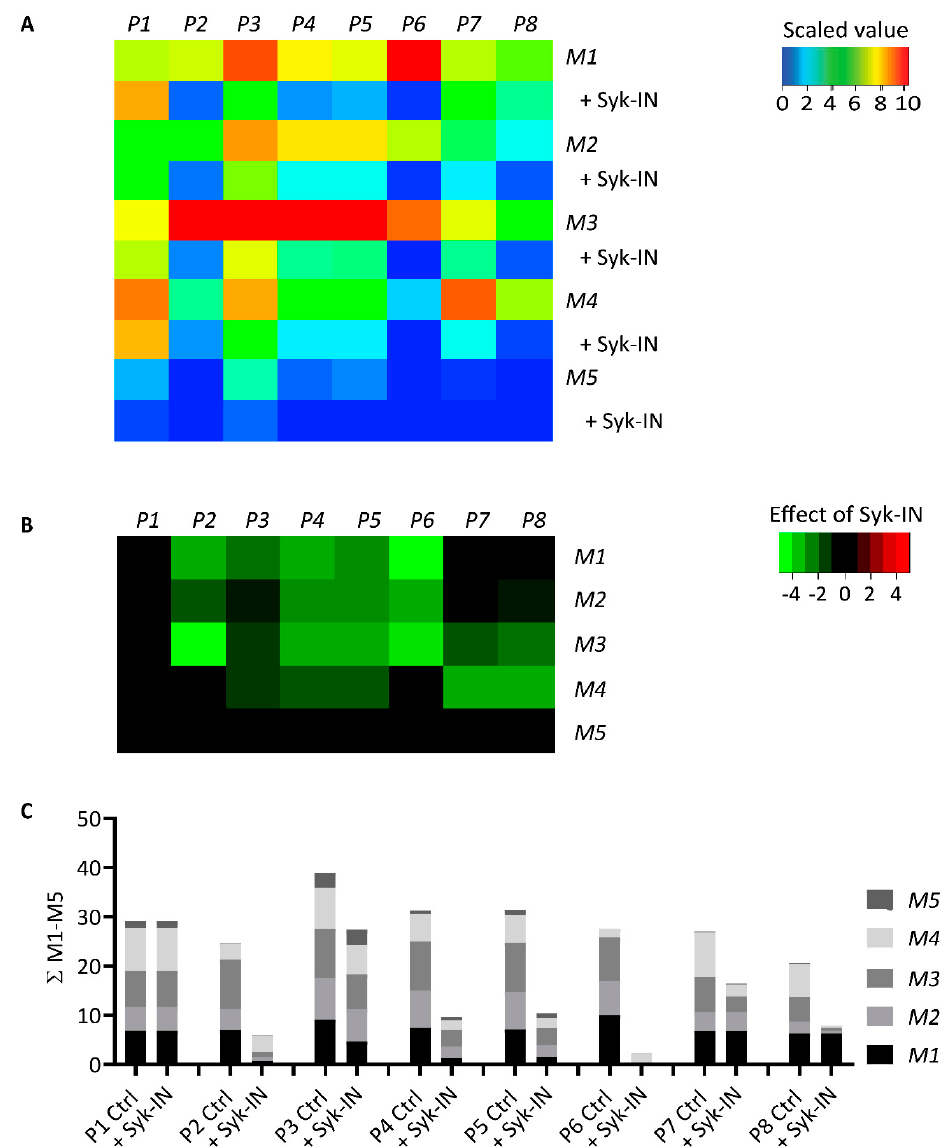
Figure 3. Effect of Syk inhibition on parameters of thrombus formation on immobilized collagen peptides. Blood samples pre-incubated with vehicle (Ctrl) or Syk-IN (20 µM) flowed over microspots M1–5, and the thrombi formed were imaged to obtain parameters P1–8, as in Figure 2. The effects of Syk-IN were assessed per blood sample, surface, and parameter. Mean values from individual blood samples ( n = 5–7) were univariate-scaled to 0–10 per parameter across all surfaces M1–9. ( A ) Heatmap of scaled parameters, demonstrating the mean effects of Syk-IN. The rainbow color code indicates scaled values between 0 (blue) and 10 (red). ( B ) Subtraction heatmap representing the scaled effects of Syk-IN, filtered for relevant changes ( p < 0.05, paired Student’s t -test per surface and parameter). The color code represents decreases (green) or increases (red) in comparison to control runs. ( C ) Cumulative inhibitory effect per parameter over all microspots, indicating relevant changes.